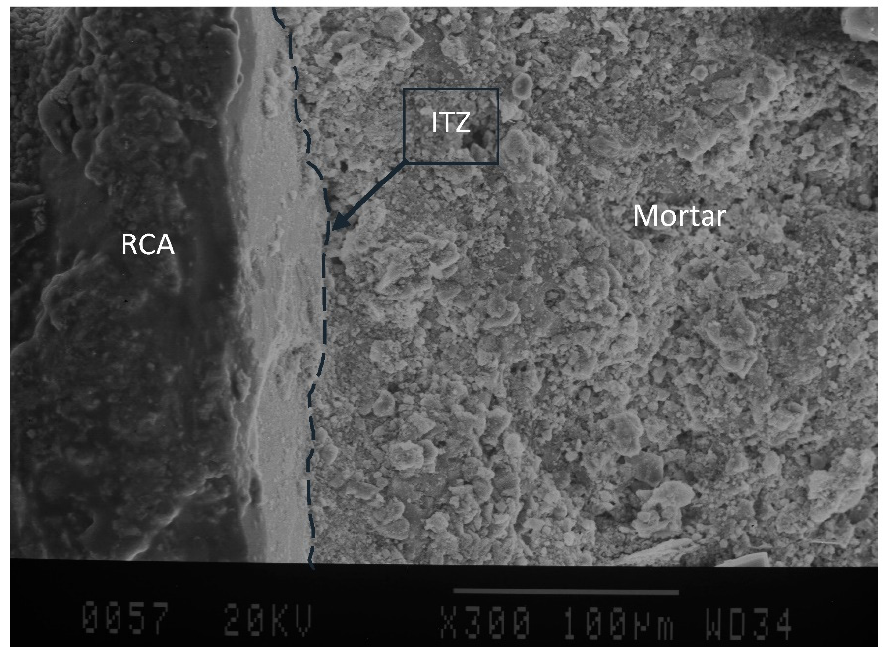
Figure 12. Surface deterioration of recycled concrete aggregates exposure to freeze and thaw cy- cles.